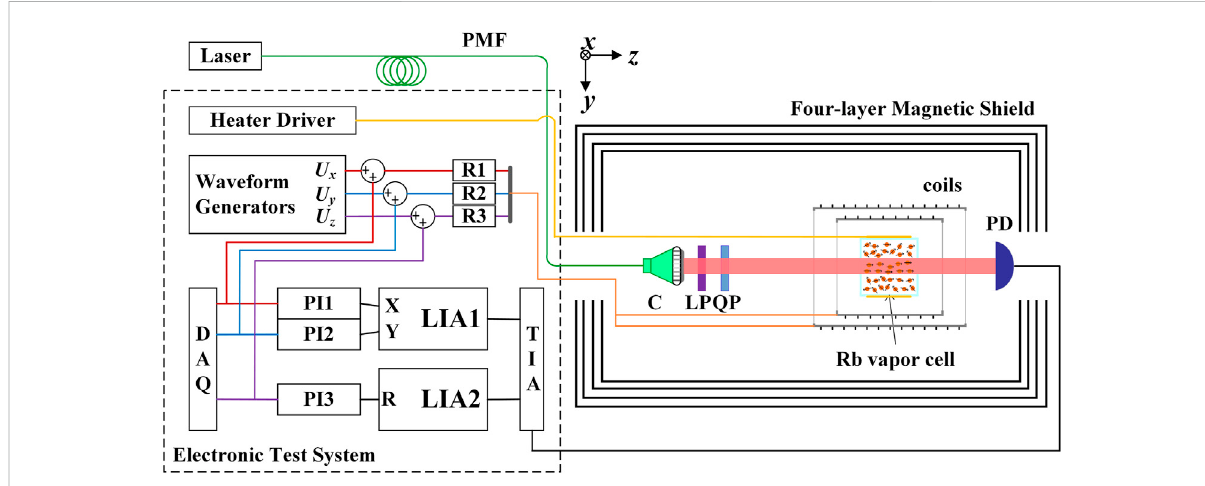
FIGURE 4 Theexperimentalsystemschematicofoursingle-beam closed-loop triaxialzero- fi eldOPM. PMF:polarizationmaintaining fi ber;C:collimating lens; LP: linear polarizer; QP: quarter-waveplate; PD: photodiode; TIA: transimpedance ampli fi er; LIA1 and LIA2: lock-in ampli fi ers; PI1, PI2, and PI3: proportional and integral controllers; DAQ: data-acquisition; R1, R2, and R3: resistors.